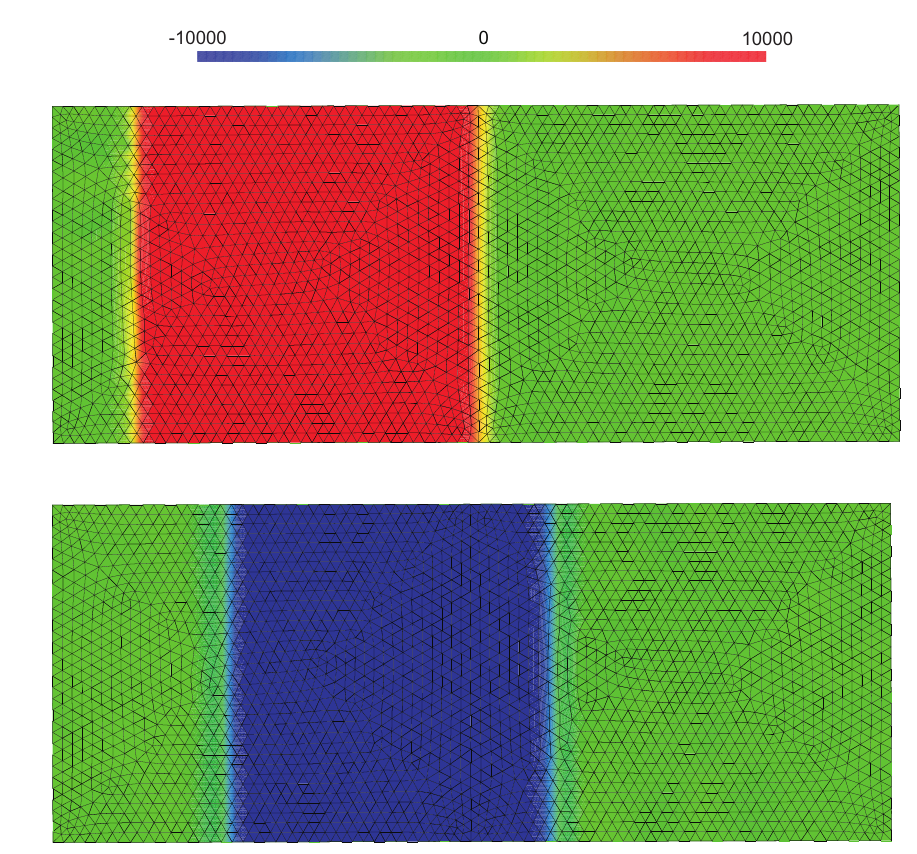
Figure 8. Wave propagating along a homogeneous rod discretized with a two-dimensional unstructured mesh: longitudinal stress field at (top) t = 0 . 5 · 10 − 2 s and (bottom) t = 1 . 8 · 10 − 2 s. 0-10000